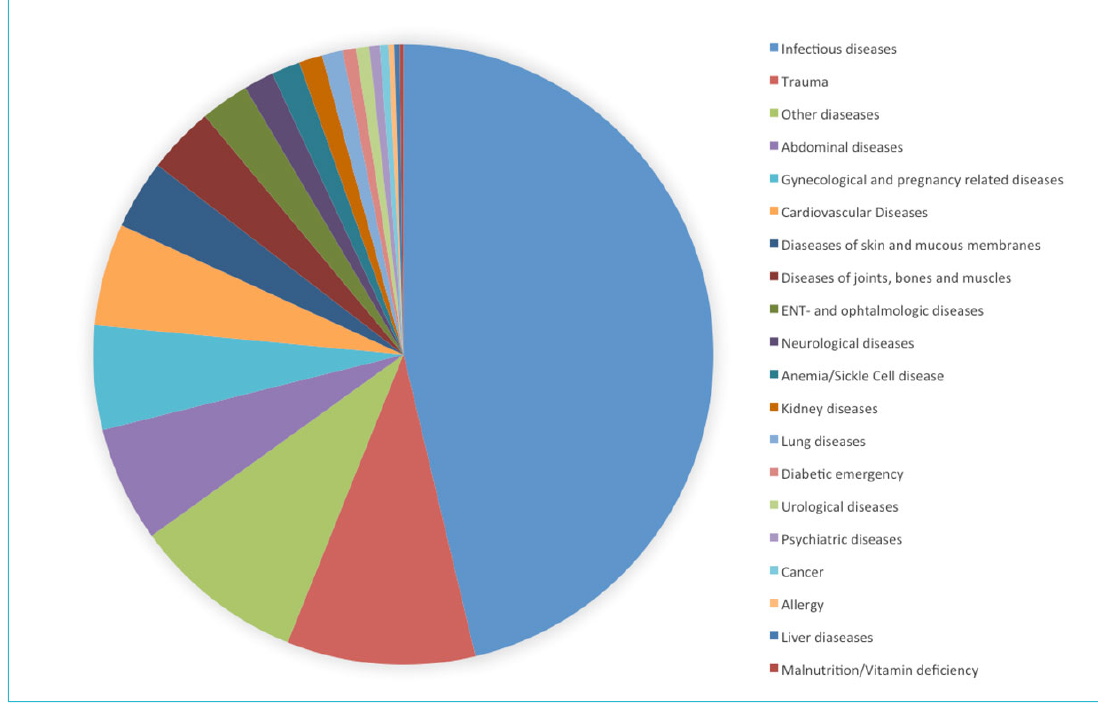
Table 3: Most frequent diagnoses in different age groups (simplified diagnosis group 1). A total of 129 patients are not included in the table, because their age was not as- sessed. In adults >50 years, GI-infections and urological diseases are of equal ranking. Children <5 years (n = 8902)